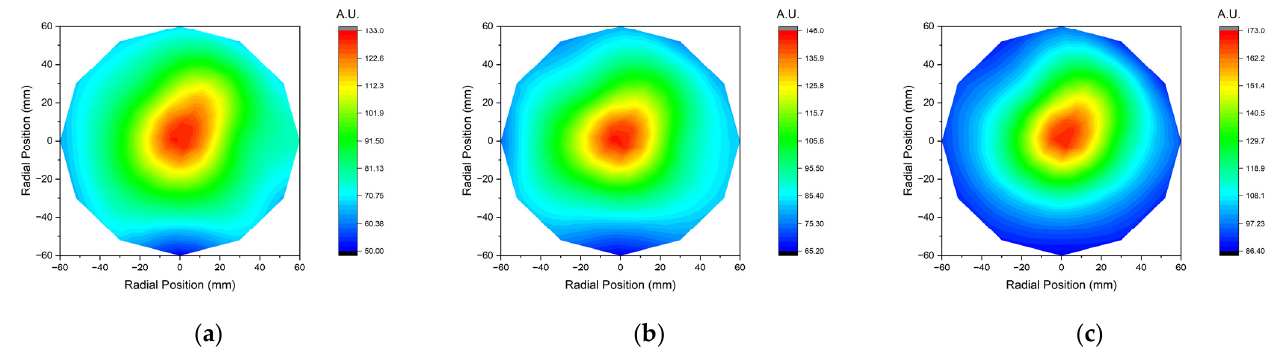
Figure 11. Contour map of ion current measured by IEMS according to pressure; ( a ) 30 mTorr, ( b ) 50 mTorr and ( c ) 70 mTorr. All data were acquired 30 s after plasma generation for stabilization.